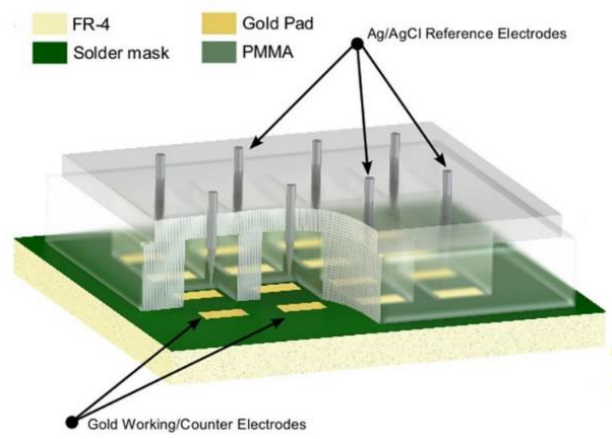
Figure 5. A three-dimensional representation of the fabricated prototype PCB-based sensor for the detection of tuberculosis using an enzyme-linked immunosorbent assay (ELISA). Reproduced from